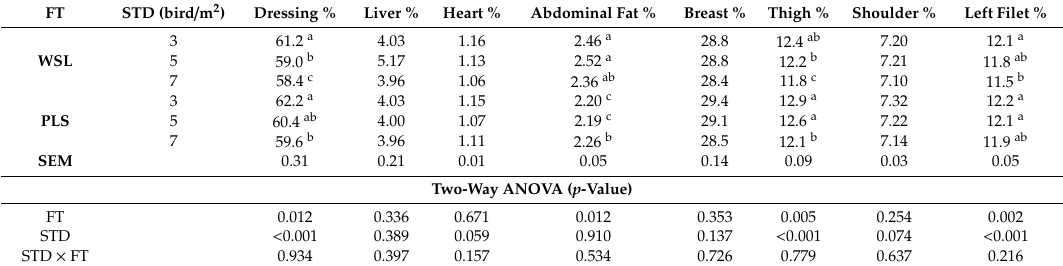
Table 3. E ff ects of stocking density (STD) and flooring type (FT) on carcass traits of Pekin ducks at 49 days of